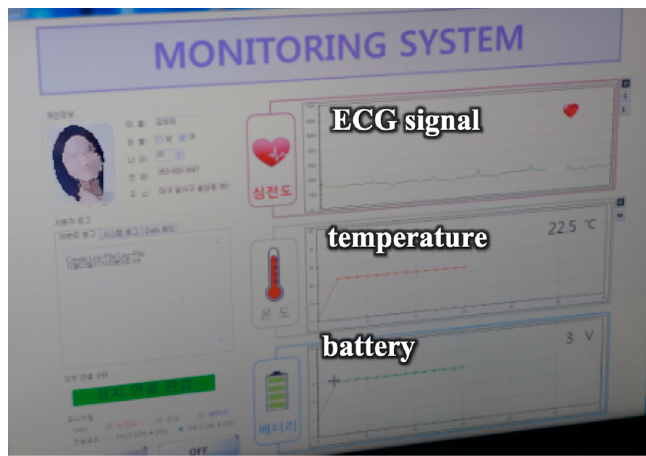
Figure 5. Sensed bio-signals and battery voltage level on the monitoring program.